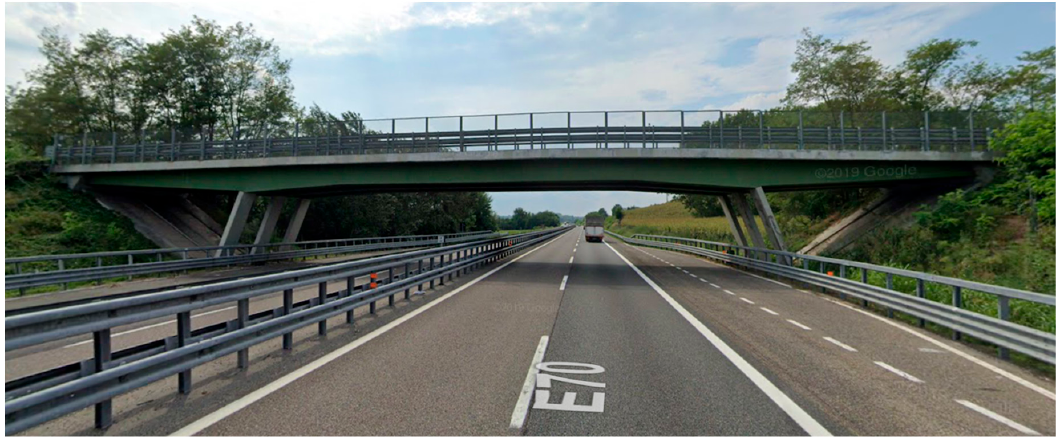
Figure 7. Street view of one of the overpasses of the Italian Highway A21 (source Google Maps).